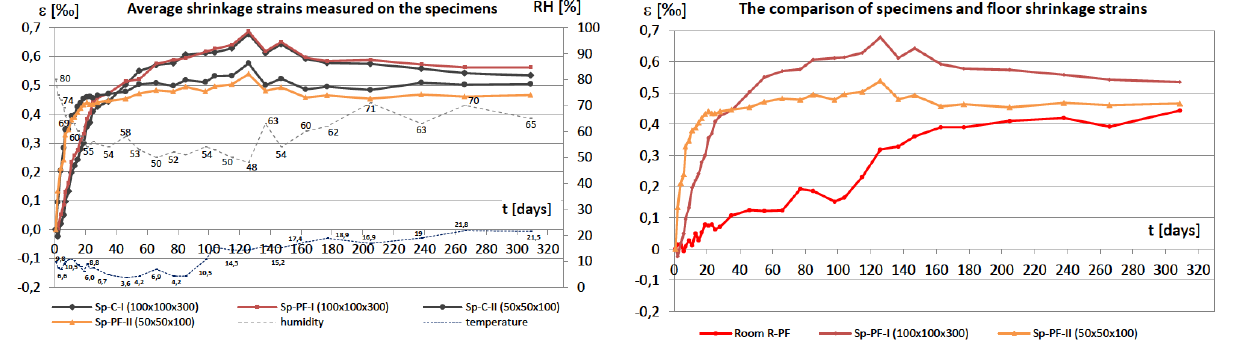
Figure 7: Graph of average increases in systolic strains measured on laboratory specimens and screed with polypropylene fibre